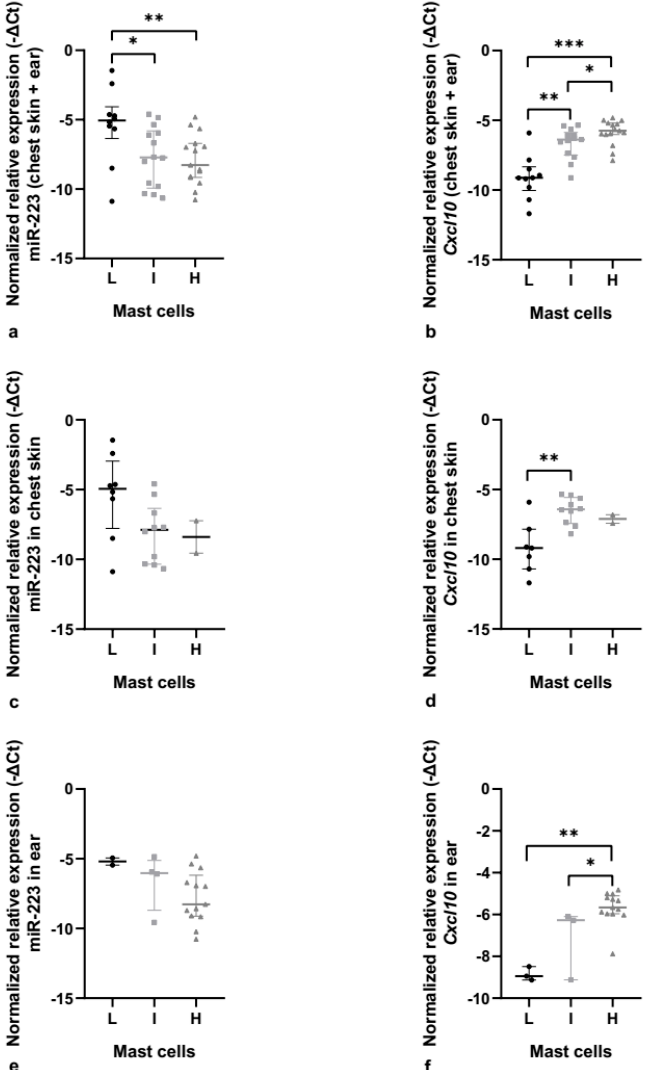
Figure 6. MiR-223 and Cxcl10 relative expression in K14-HPV16 transgenic mice. ( a ) . MiR-223 relative expression in chest skin and ear tissue, together. There are statistically significant differences between the low and intermediate mast cell counts (* p < 0.05) and between the low and high mast cell counts (** p < 0.01). ( b ) . Cxcl10 relative expression in chest skin and ear tissue, together. We observed statistically significant results between the low and intermediate mast cell counts (** p < 0.01), between the low and high mast cell counts (*** p < 0.001), and between the intermediate and high mast cell counts (* p < 0.05). ( c ) . Normalized relative expression of miR-223 in chest skin. ( d ) . Normalized relative expression of Cxcl10 in chest skin. Statistically significant differences were